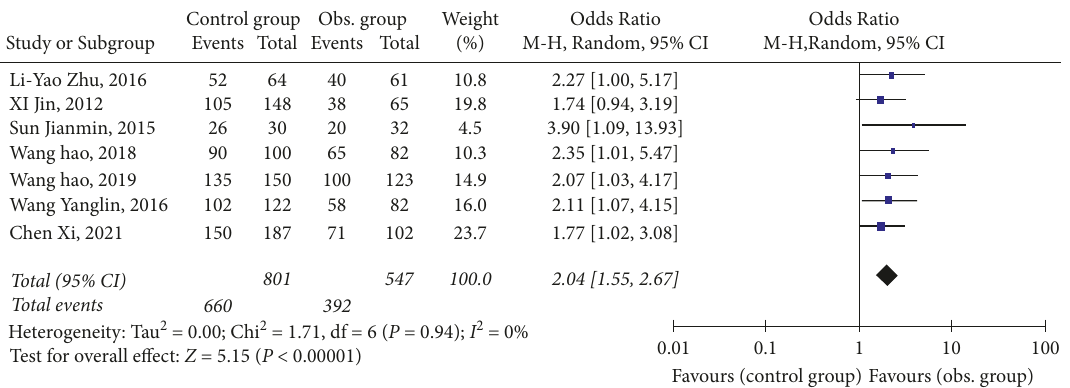
Figure 3: Data of ALT normalization after 48-week antivirus.